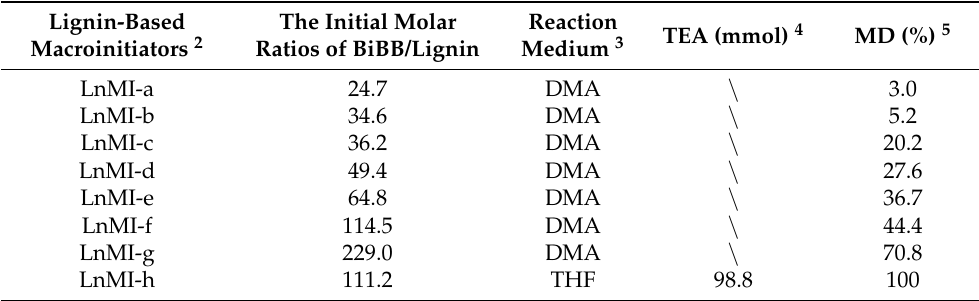
Table 1. The selected conditions for synthesis of lignin-based macroinitiators (LnMIs) with different modification degrees 1 .